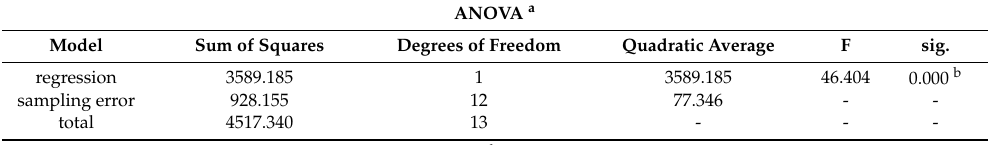
Table 9. Variance analysis for wheel-tracking test and first modulus of PLT ( Φ 600mm) at crown. ANOVA a Model Sum of Squares